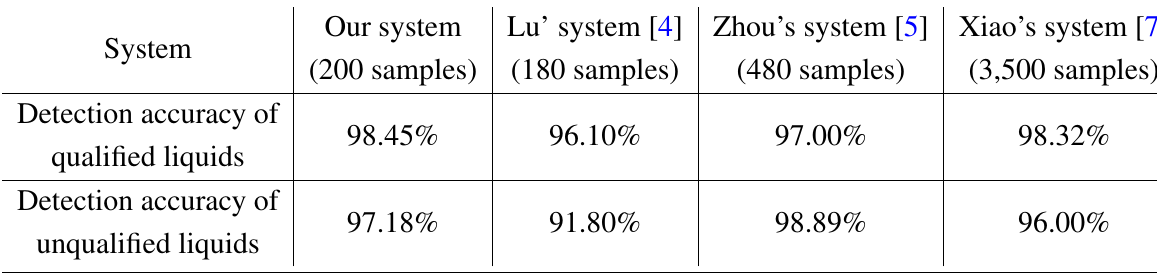
Table 4. Comparison among our system and other systems.